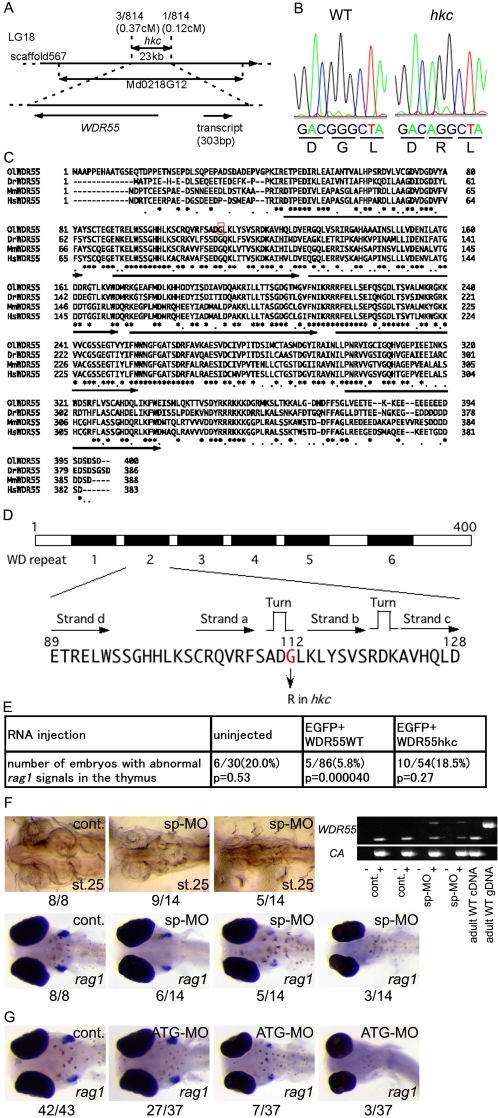
A missense mutation in WDR55 is responsible for hkc phenotype.(A) hkc was mapped on linkage group (LG) 18 and confined in the 23 kb region on scaffold 567. Recombination rates of 407 hkc embryos from hkc/+ (cab-derived)×kaga crosses and cM distances from hkc to neighboring markers are shown. These markers are located in a single BAC Md0218G12. Indicated two genes were predicted in the mapped region. (B) Sequences within the WDR55 coding region of WT (left) and hkc (right) genomic DNA and predicted amino acid sequences. (C) Predicted amino acid sequence of medaka (Ol) WDR55 was compared with zebrafish (Dr), mouse (Mm), and human (Hs) WDR55 sequences. Asterisks and dots indicate residues that are shared among all four species and three species, respectively. Arrows indicate WD repeat domains. Red box indicates glycine residue that is replaced with arginine in hkc mutants. (D) Predicted structure of medaka WDR55 protein. Filled boxes indicate WD repeat domains. Amino acid residues and predicted secondary structures of the second WD repeat domain are also shown. (E) 1-cell-stage embryos from +/hkc×+/hkc matings were injected with WT- or hkc-derived WDR55 mRNA and EGFP mRNA, and whole-mount in situ hybridization using rag1 probe was carried out at 6 dpf. P-values were calculated using κ-square test. (F) 50 µM of morpholino that blocks splicing of WDR55 (sp-MO) was injected into WT embryos. Three images appearing on top left show dorsal views of control embryos (cont.) and morphants (sp-MO) at stage 25. Four images appearing at the bottom show ventral views of control (cont.) and 5-dpf morphants (sp-MO) hybridized with rag1 probe. Numbers below images indicate the numbers of embryos showing phenotypes of the images over the numbers of total embryos examined. Top right images show ethidium bromide (EtBr)-stained gels of RT-PCR products for two WDR55 exons neighboring the position of splicing-inhibiting morpholino. Total RNAs from two individual control embryos (cont.) and two individual morphants (sp-MO) at stage 25 were examined. cDNA was synthesized in the absence (−) or presence (+) of reverse transcriptase. Adult WT cDNA and genomic DNA were also amplified. cDNA for cytoplasmic actin (CA) was amplified to verify the quality of cDNA synthesized. (G) 50 µM of morpholino that was designed to block translation of WDR55 mRNA was injected into WT embryos. Three images show ventral views of control (cont.) and 6-dpf morphants (ATG-MO) hybridized with rag1 probe. Numbers below images indicate the numbers of embryos showing phenotypes of the images over the numbers of total embryos examined.